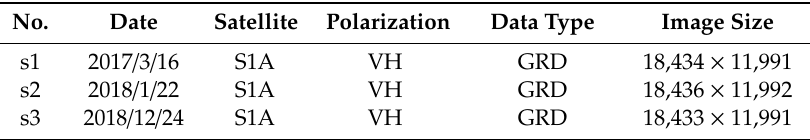
Table 1. Basic information on the experimental data.